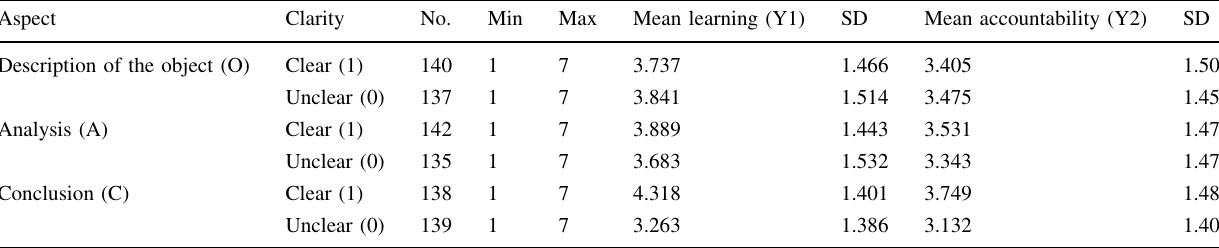
Table 5 Means for each dependent variable